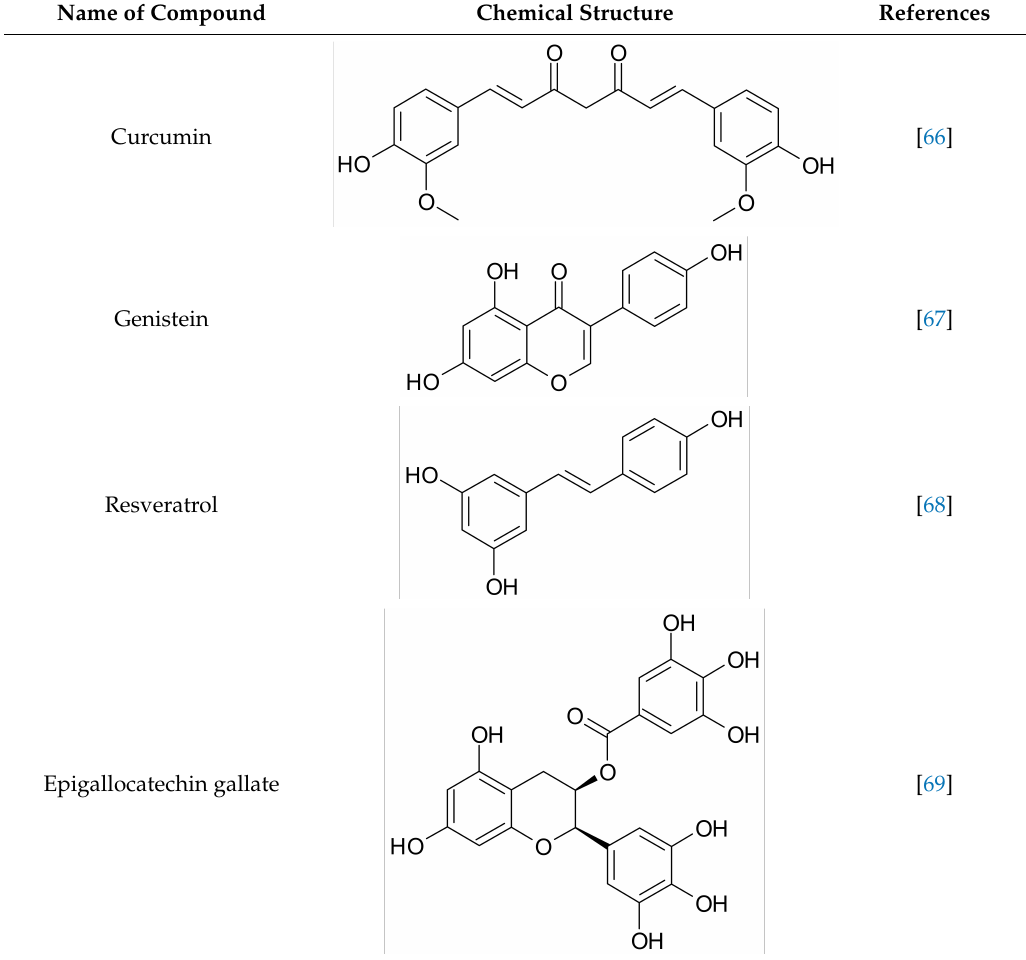
(Table 2). In MCF-7 breast cancer cell line, the use of resveratrol induced an apoptotic e ff ect and inhibited cell growth via the caspase-9 Akt pathway [72]. Other studies found that resveratrol inhibited NF- κ B, a regulator of Bcl-2 expression as well as calpain protease activity in MCF-7 breast tumor cells